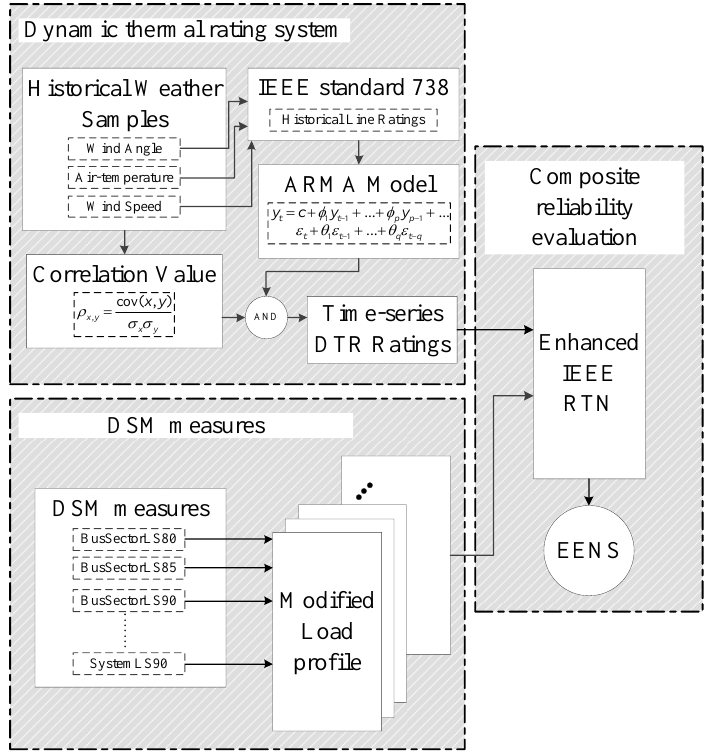
Figure 8. An overview of the proposed methodology for the joint composite reliability evaluation of DSM and the DTR system.